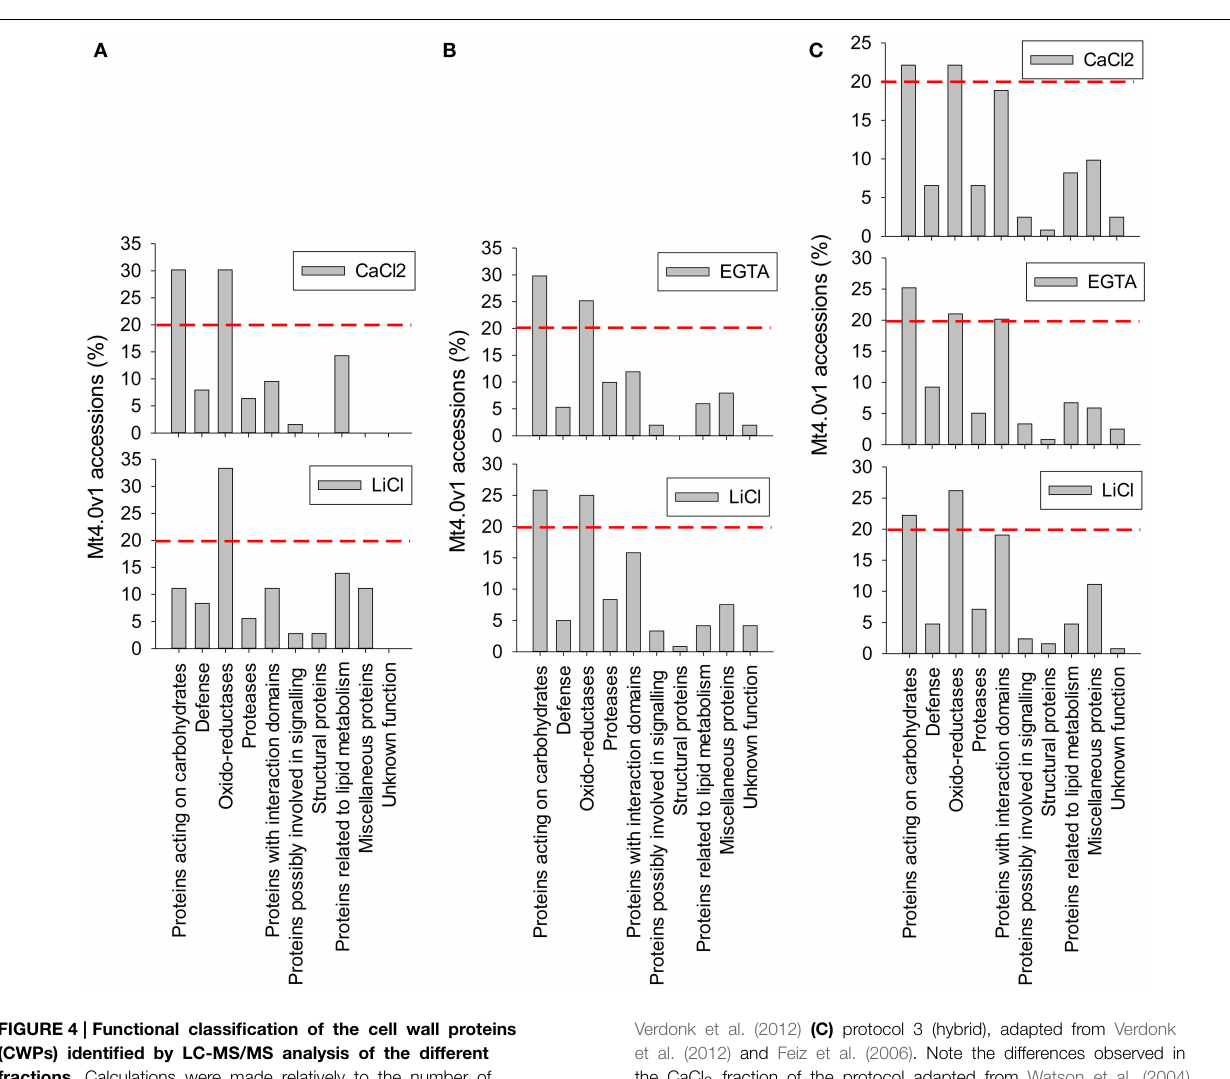
Verdonk et al. (2012) (C) protocol 3 (hybrid), adapted from Verdonk et al. (2012) and Feiz et al. (2006). Note the differences observed in the CaCl 2 fraction of the protocol adapted from Watson et al. (2004) (A) and the CaCl 2 fraction of the “hybrid” protocol (C) . These differences are related with the 2 different procedures of cell wall isolation, the first based on filtration on Büchner devices, the second being based on washes in various sucrose